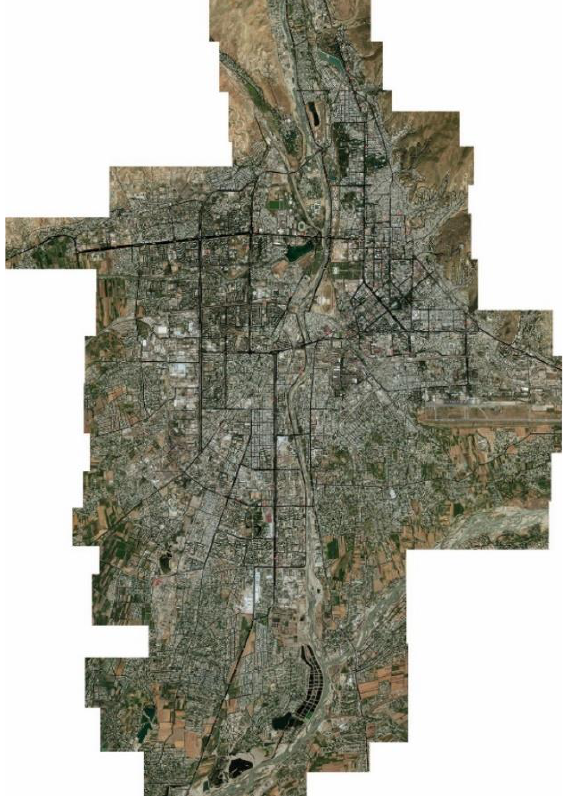
Figure 2. Aerial photographic plates of Dushanbe (courtesy of the Young Generation of Tajiki-